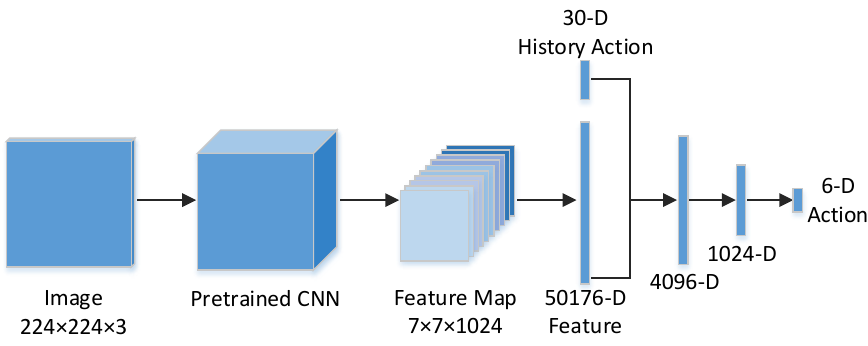
Figure 3. The Deep Reinforcement Learning Detection